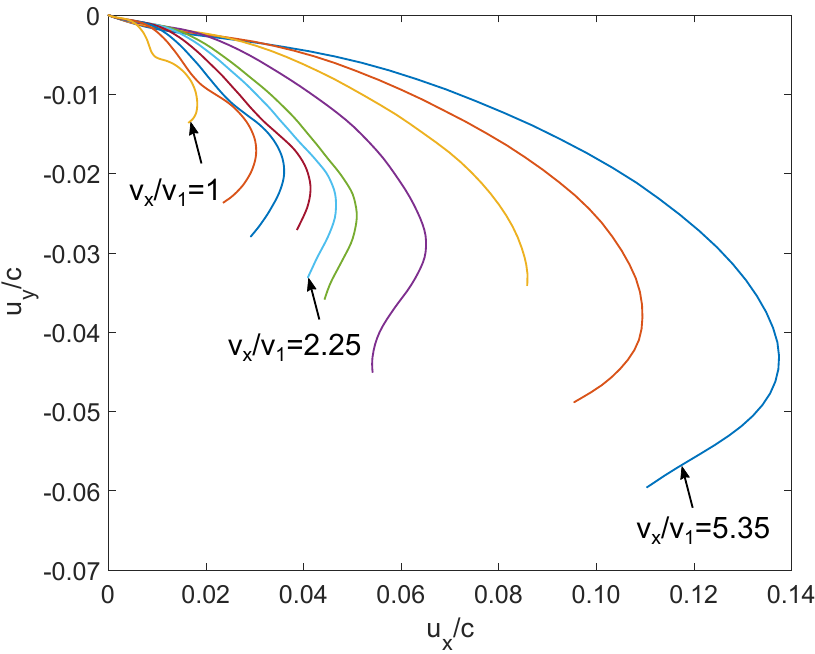
Figure 7. Normalized translation of centre of rotation of blade’s profile at r / R blade = 0.99 radial location, for the different velocities of the killer whale at x